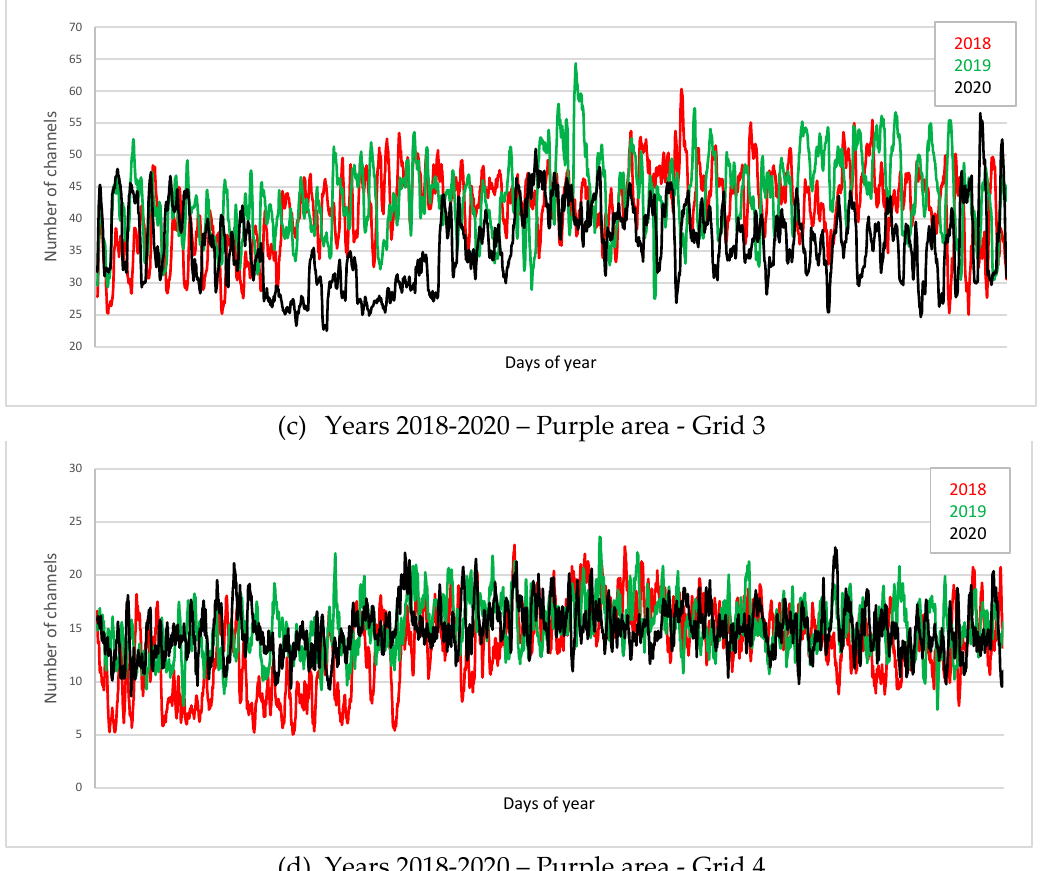
Figure 12. Results corresponding to the number of channels constituted from 2018 to 2020 in the purple geographical area under study.